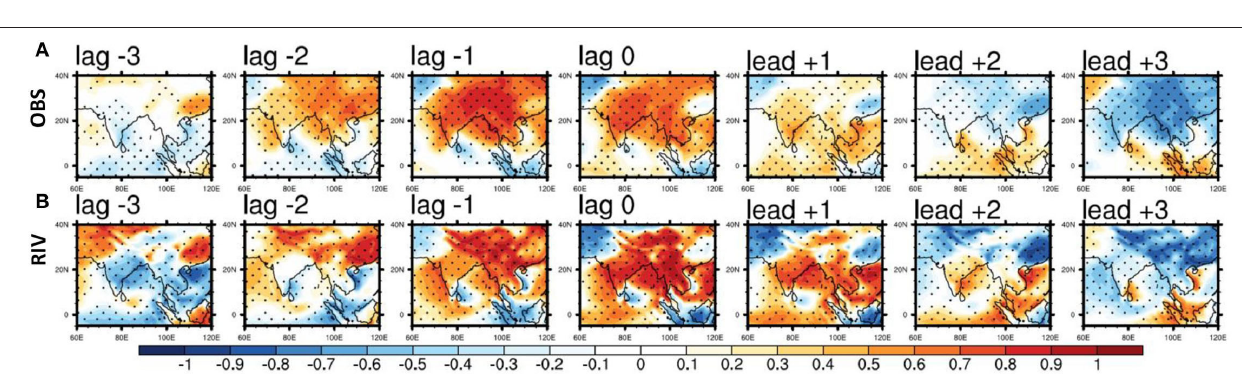
and northeastern India in observations. RIV also